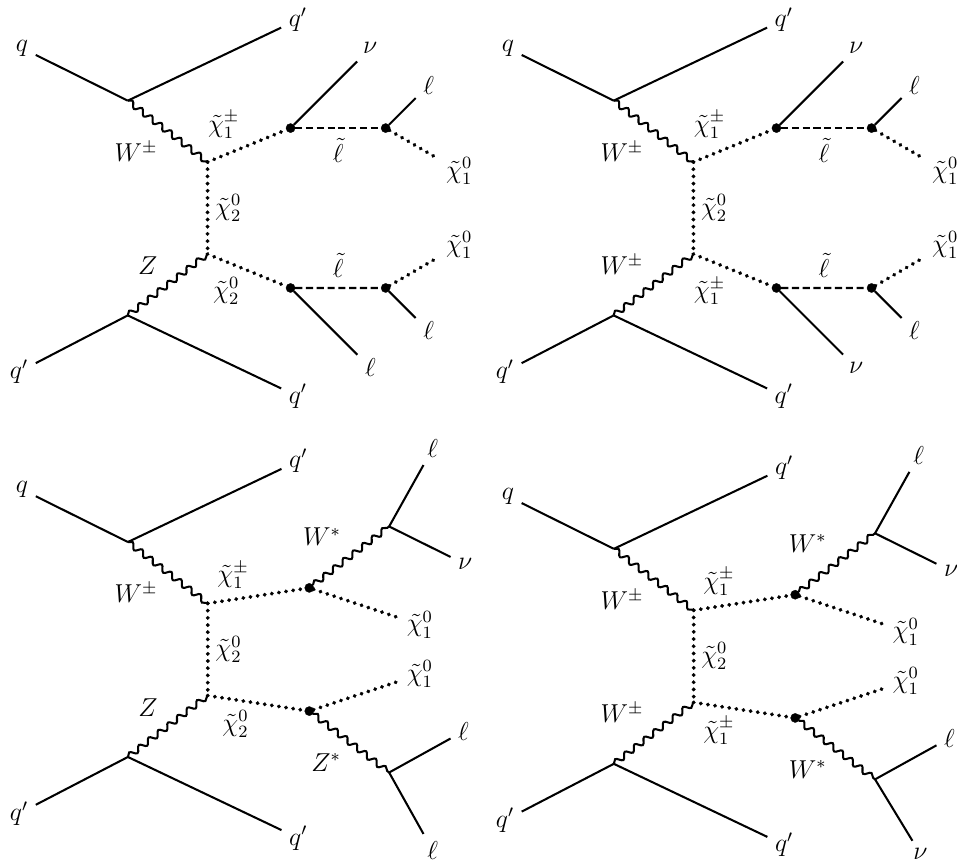
Figure 1 . Representative Feynman diagrams of (left) chargino-neutralino and (right) chargino- chargino pair production through vector boson fusion, followed by their decays to leptons and the LSP (cid:31) 0 via a light slepton (top row) or a W (cid:3) = Z (cid:3) (bottom row). Although these representative e 1 diagrams show multiple leptons in the (cid:12)nal state, the compressed mass spectra scenarios of interest result in low- p leptons, making it unlikely to reconstruct and identify more than one T